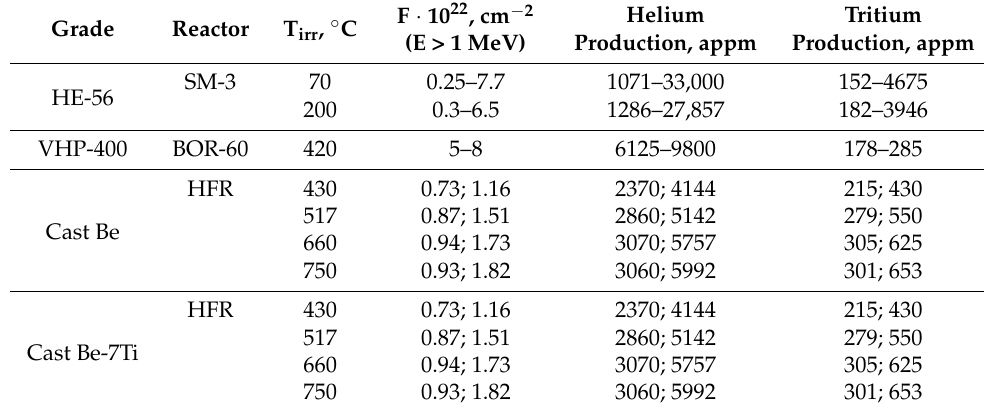
Table 2. Irradiation parameters of beryllium specimens. Cast Be and Be-7Ti were irradiated at four temperatures in two campaigns of HIDOBE-01 (H-1) and HIDOBE-02 (H-2) to two different neutron fluences, helium and tritium productions (left sub-column in each column refers to H-1, right to H-2). Grade T irr , ◦